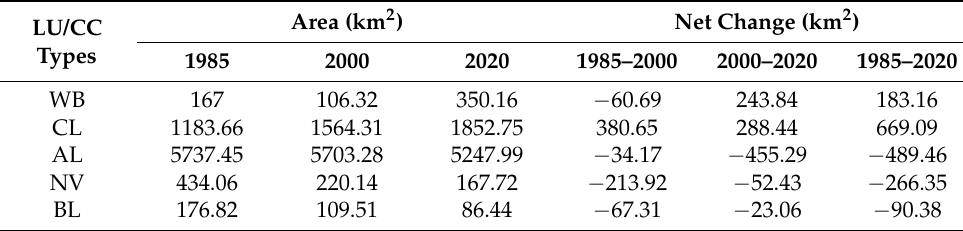
Table 4. Statistic of LULC area distribution (area in km 2 ) and net changes (km 2 ) from 1985 to 2020.